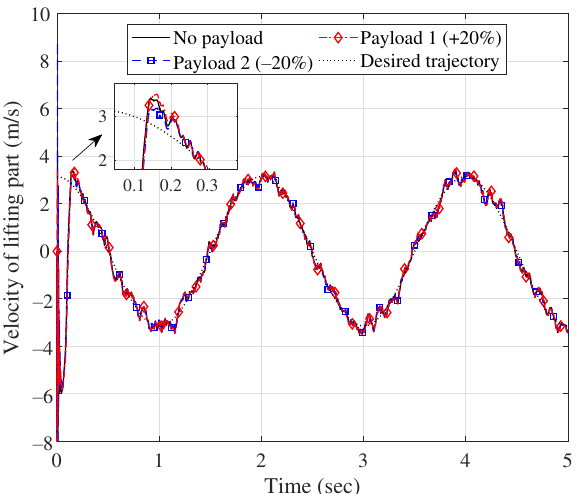
Figure 18. Velocity of lifting part (Group 3).